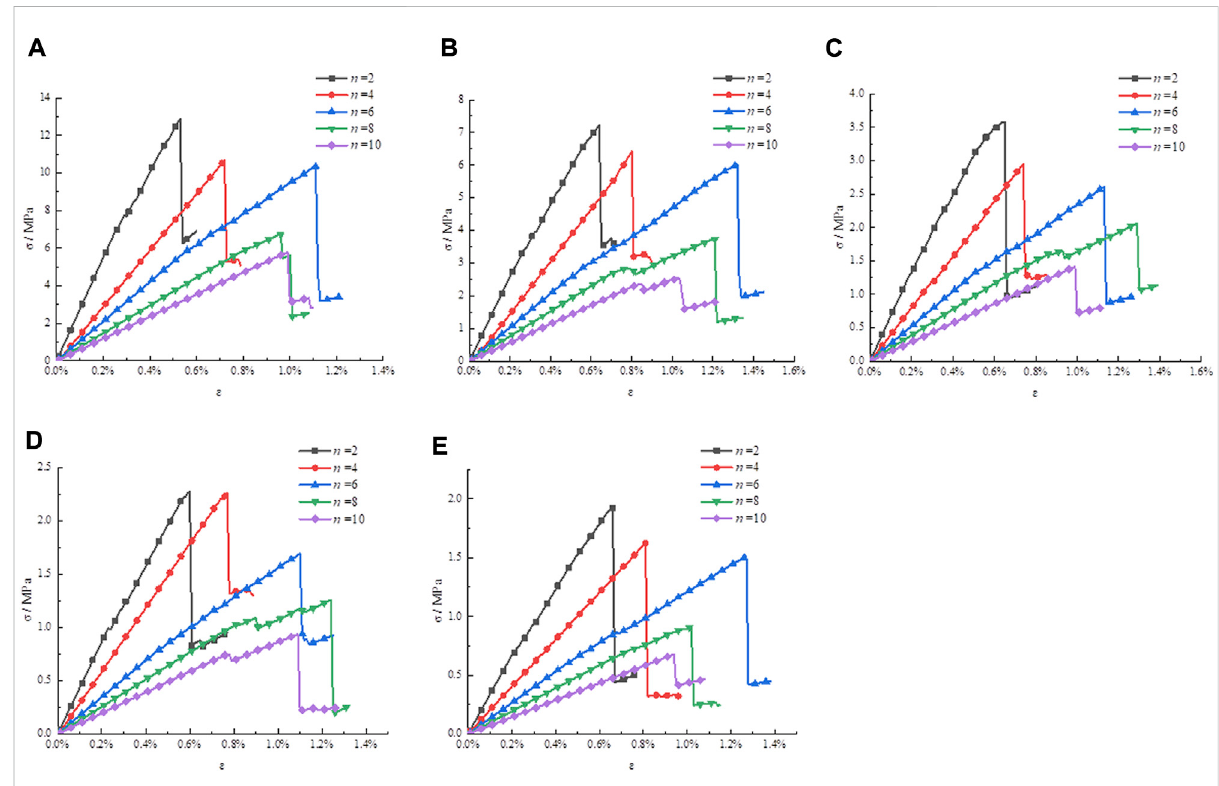
FIGURE 1 Stress – strain curves with different NPJs. (A) l = 100 mm, (B) l = 200 mm, (C) l = 400 mm, (D) l = 600 mm, and (E) l = 800 mm.